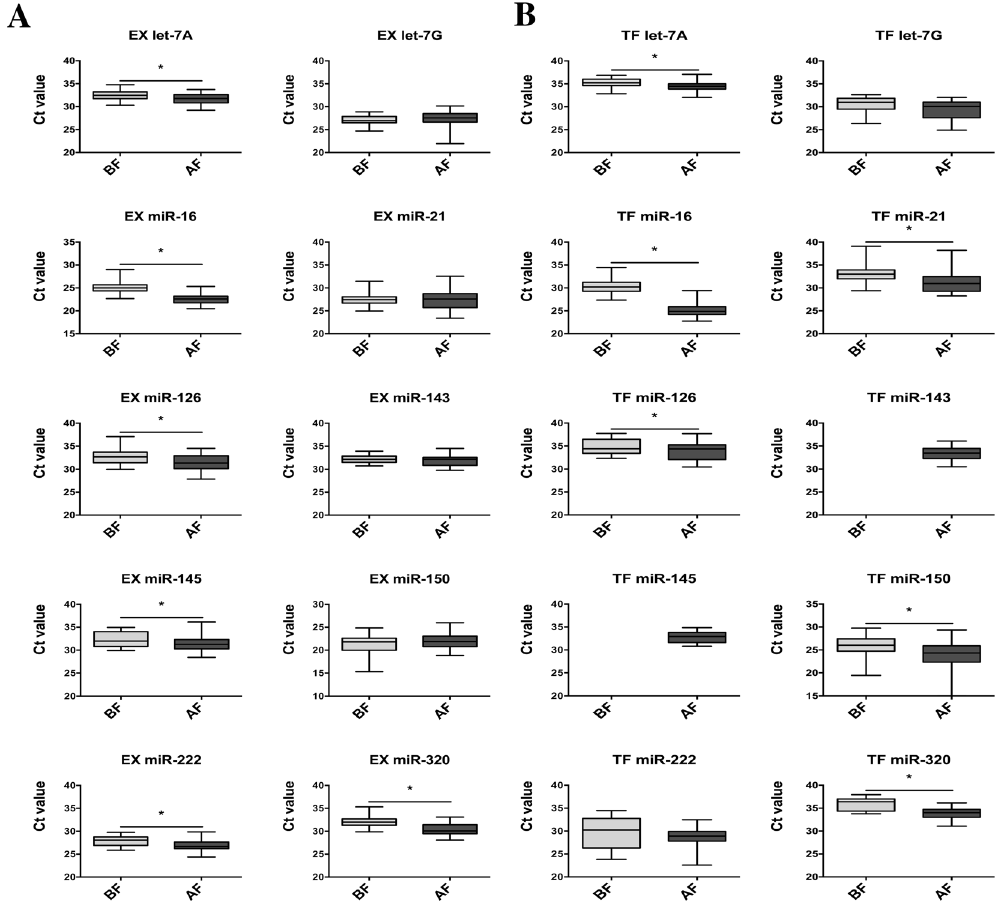
Figure 2. ( A ) Comparison between Ct values of miRNAs obtained from frozen exosomes isolated from fresh plasma (BF) or fresh exosomes isolated from frozen plasma (AF) using the miRCURY Exosome Isolation Kit (Exiqon). ( B ) Comparison between the Ct values of miRNAs obtained from frozen exosomes isolated from fresh plasma (BF) or fresh exosomes isolated from frozen plasma (AF) using the Total Exosome Isolation Kit (Thermo Fisher Scientific). All the data are presented as the mean values (n = 7) (error bars correspond to the standard deviation). * p <